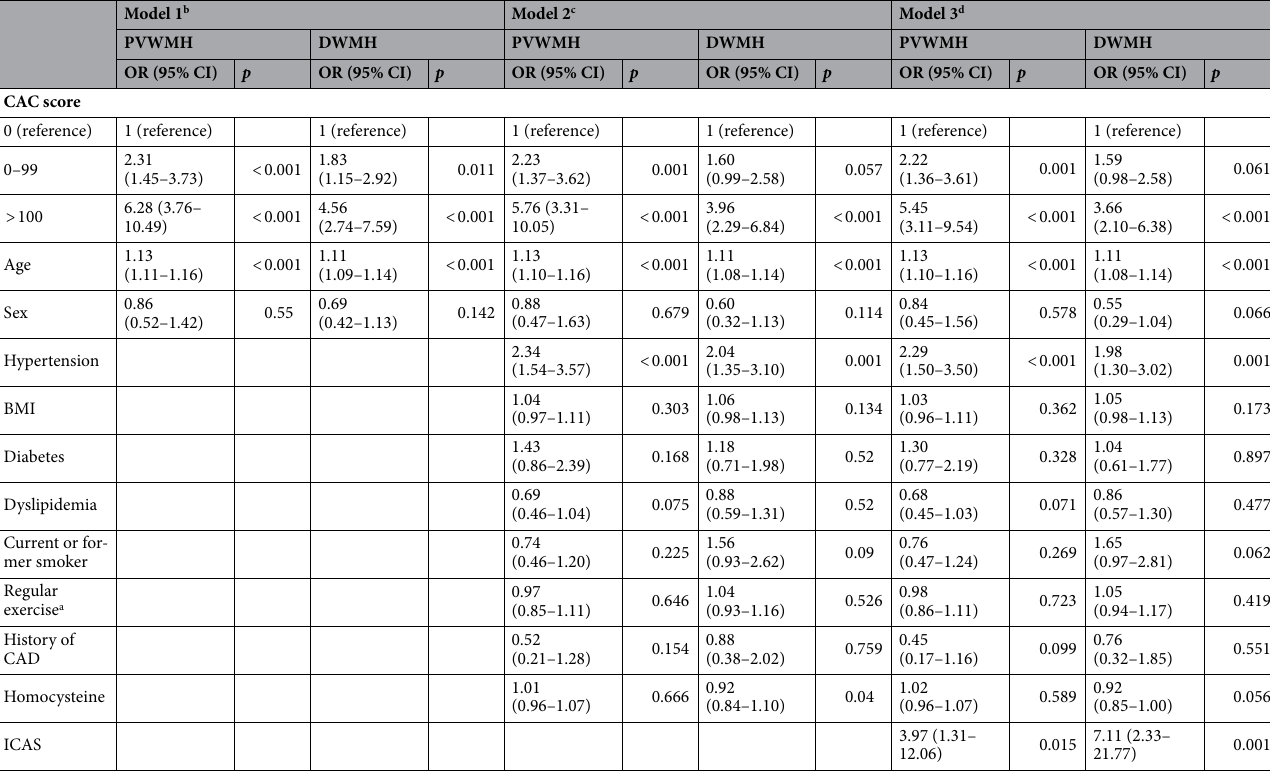
Table 3. Multivariable analysis for PVWMH and DWMH after adjusting for confounders. PVWMH Periventricular white matter hyperintensity, DWMH Deep white matter hyperintensity, ICAS Intracranial artery stenosis, CAC Coronary artery calcium, CAD Coronary artery disease, CI Confidence interval, OR Odds ratio. a Regular engagement in vigorous exercise for more than 10 min at least 3 times per week. b Adjusted for age and sex. c Adjusted for Model 1 + atherosclerotic risk factors (BMI, hypertension, diabetes, dyslipidemia, current or former smoker, regular exercise, history of CAD, and homocysteine level). d Adjusted for Model 2 +